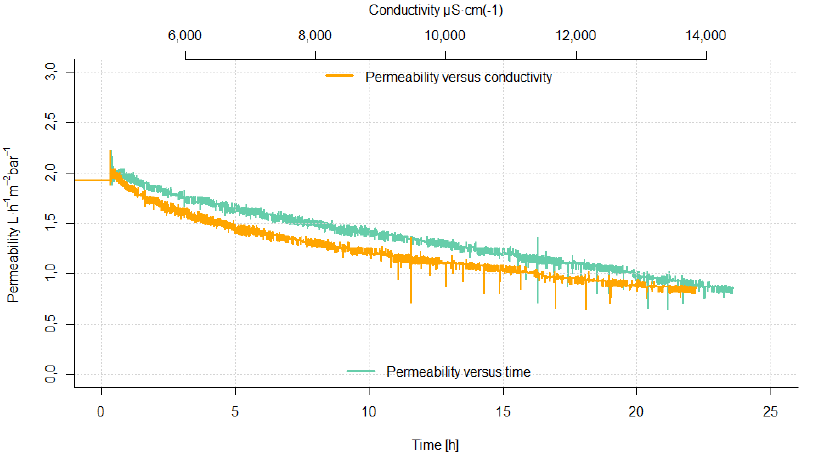
Figure 9. Permeability for reverse osmosis with flat sheet membrane BW30 at 20